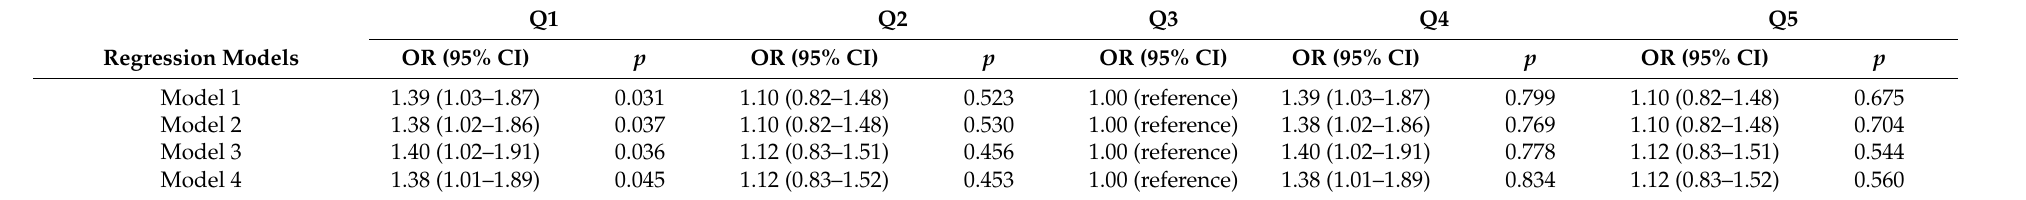
Table 2. Logistic regression models for low hand grip strength by serum vitamin E levels grouped by